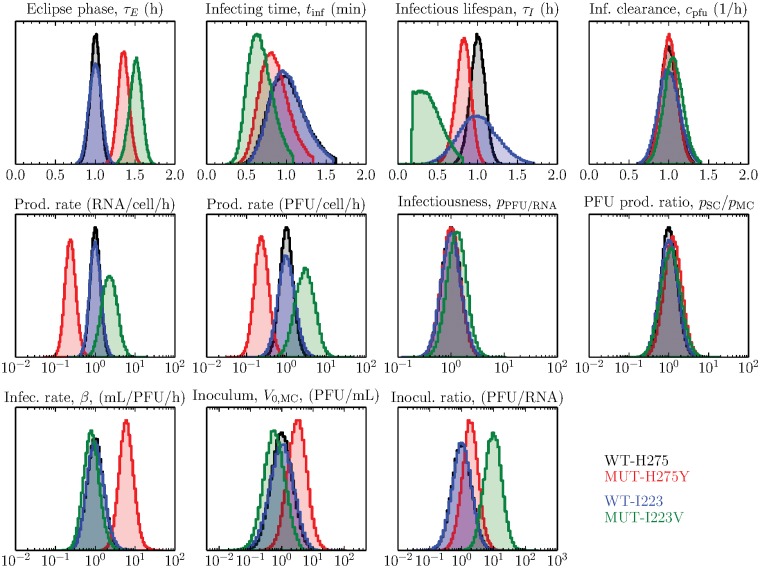
Impact of the H275Y and I223V NA mutations in the H1N1pdm09 background.The probability density functions of the key viral replication parameters characterizing the fitness of the WT-H275 and MUT-H275Y H1N1pdm09 strains (from earlier work, [18]), and that of the WT-I223 and MUT-I223V strains are presented side-by-side for comparison. To facilitate the comparison across the two separate experiments, the WT distributions have been centred at one (100) and the H275Y and I223V mutants’ parameters are shown relative to their respective WT parameters.